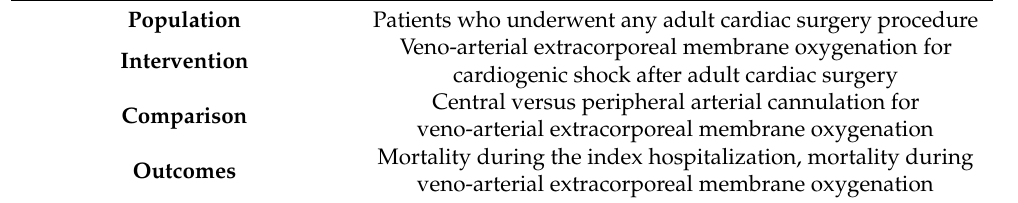
Table 1. Population, intervention, comparison, and outcomes of the present study. Population Patients who underwent any adult cardiac surgery procedure Veno-arterial extracorporeal membrane oxygenation for Intervention cardiogenic shock after adult cardiac surgery Central versus peripheral arterial cannulation for Comparison veno-arterial extracorporeal membrane oxygenation Mortality during the index hospitalization, mortality during Outcomes veno-arterial extracorporeal membrane